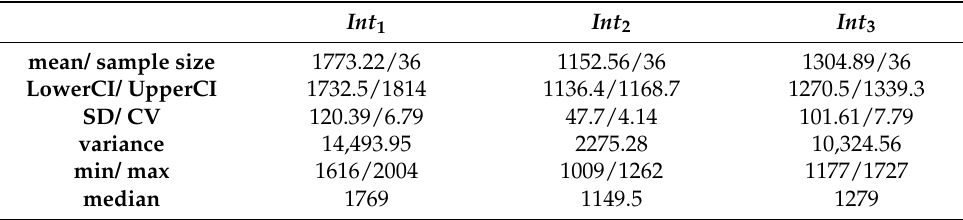
Table 4. Results of the Int 1 , Int 2 , Int 3 analysis.